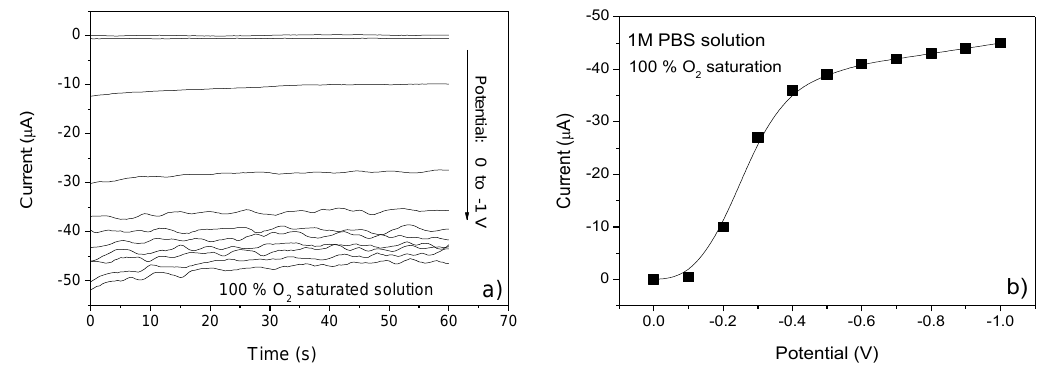
Figure 5. ( a ) Chrono-amperometric responses of the sensor obtained in 100% O 2 saturated solution at different applied potentials ranging from −0.1 V to −1 V.; ( b ) current-potential relationships.